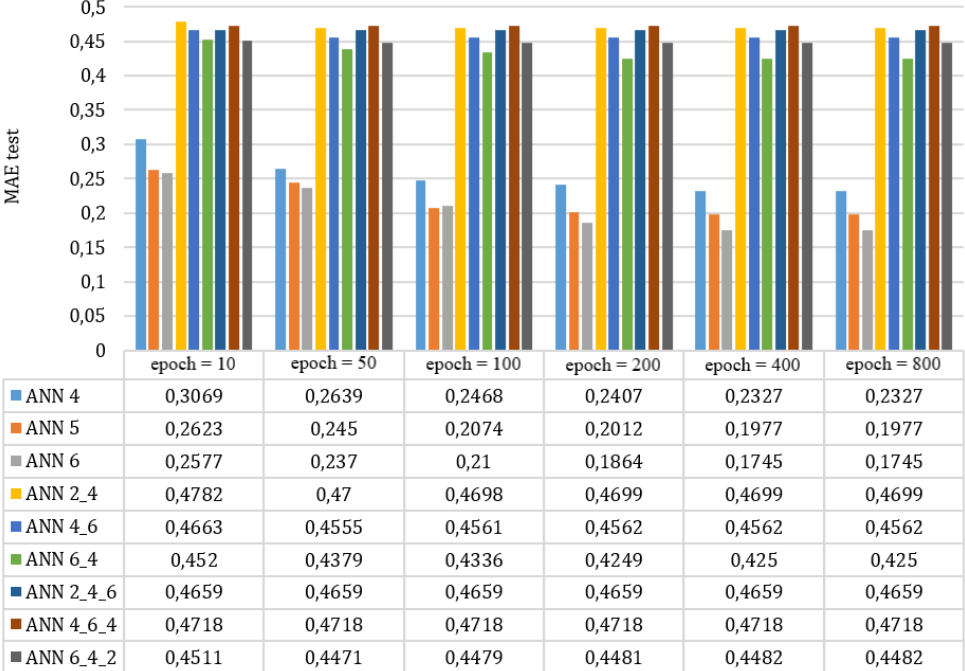
Figure 9. MAE test results of nine different ANN topologies.